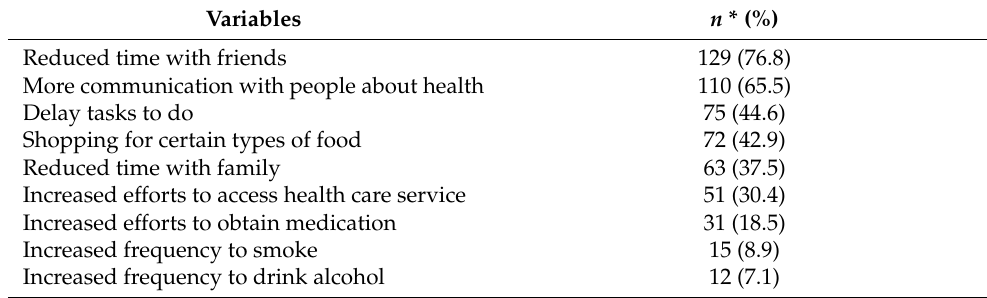
Table 5. Impact of COVID-19 on behaviors among patients with inflammatory bowel